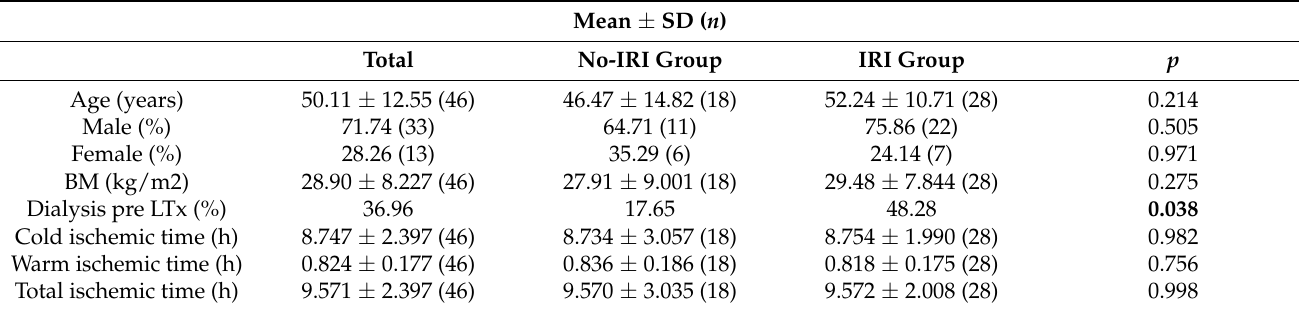
Table 1. Recipient characteristics: comparison of patients with existing or absent histo-pathological ischemia reperfusion injury (IRI). Number of patients are in round brackets. Mean with range and number of patients is in parentheses. Abbreviations: SD, standard deviation; BMI, body mass index; and LTx, liver